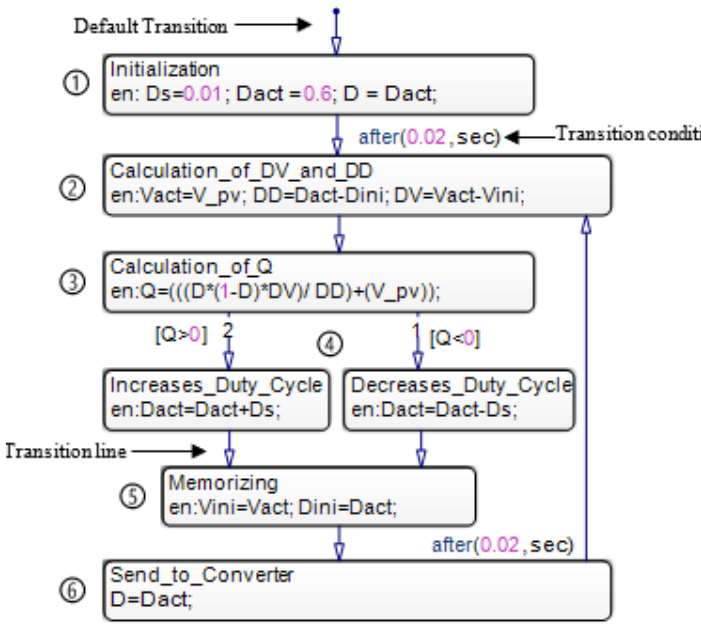
Figure 8. The Stateflow chart of the proposed CSL algorithm.